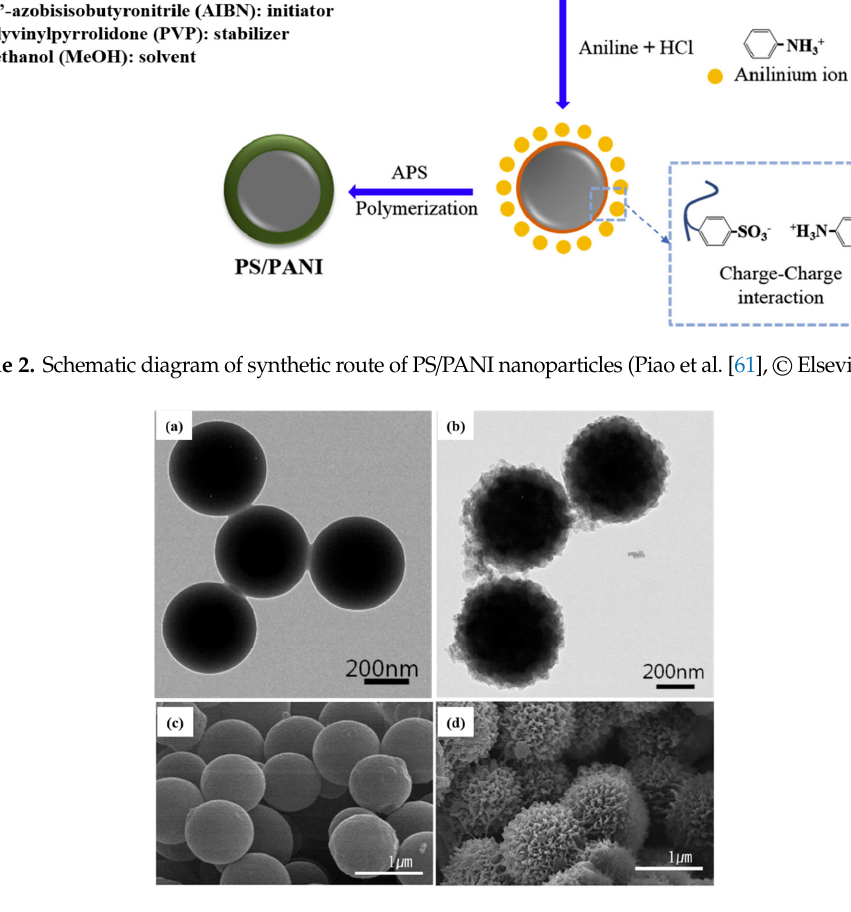
Figure 1. Morphologies of PANI coated polymeric nanoparticles: ( a , b ) TEM images of PS and PS/PANI (Piao et al. [61], © Elsevier, 2017) and ( c , d ) SEM images of PS and sea urchin-like PS/PANI (Kim et al. [66], © The Royal Society of Chemistry, 2015).